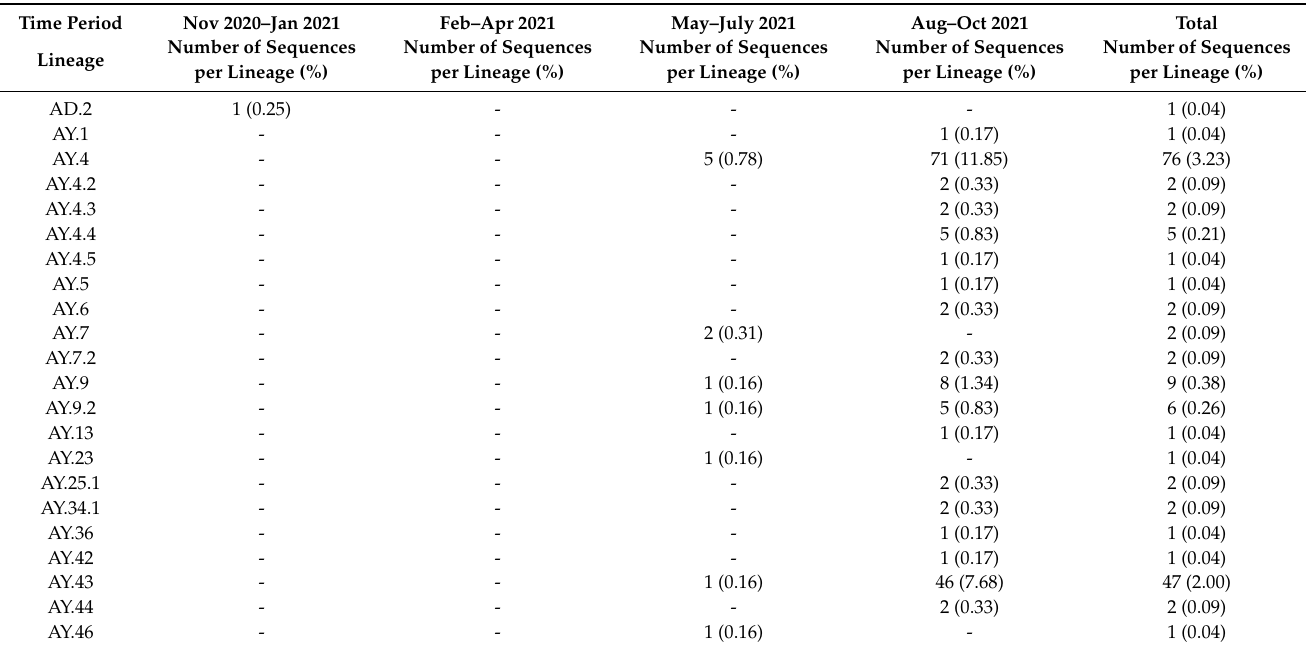
Table 1. SARS-CoV-2 lineages identified from 2352 sequences in Cyprus from November 2020